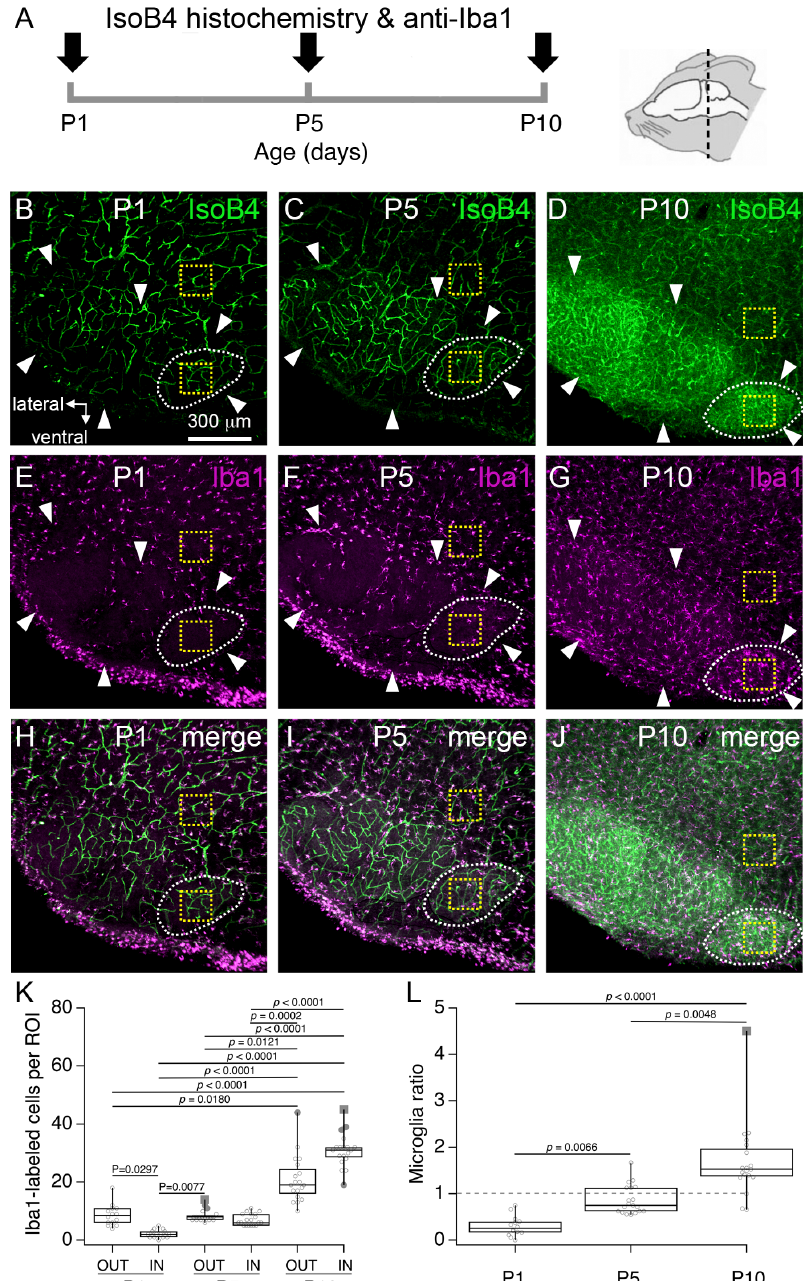
Figure 3. Changes in microglia number in the rat superior olivary complex (SOC). ( A ) Experiment outline. ( B – D) Exemplar low-magnification confocal z-stacks from P1, P5 and P10 brainstem sections show the profile of IsoB4 labeling in the SOC. ( E – G ) Anti-iba1 immunohistochemistry in the same tissue sections. ( H – J ) Merged views of IsoB4 and anti-Iba1 labeling. White arrows indicate the outline of the SOC. Dashed white lines indicate the outline of the MNTB. Yellow dashed squares indicate regions of interest (ROI) inside (IN) or outside (OUT) the MNTB. Scale bar in ( B ) applies to ( C – J ). ( K ) Number of anti-Iba1 labeled cells in IN ROI and OUT ROI at different ages. ( L ) Microglia ratio at different postnatal ages.